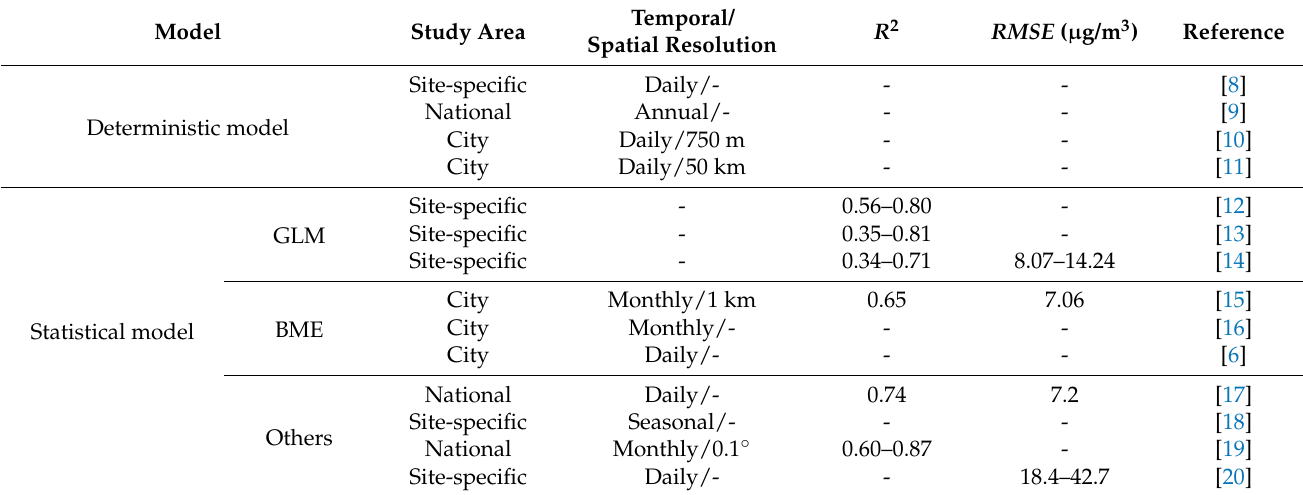
Table 1. Model survey of recent studies on GOC